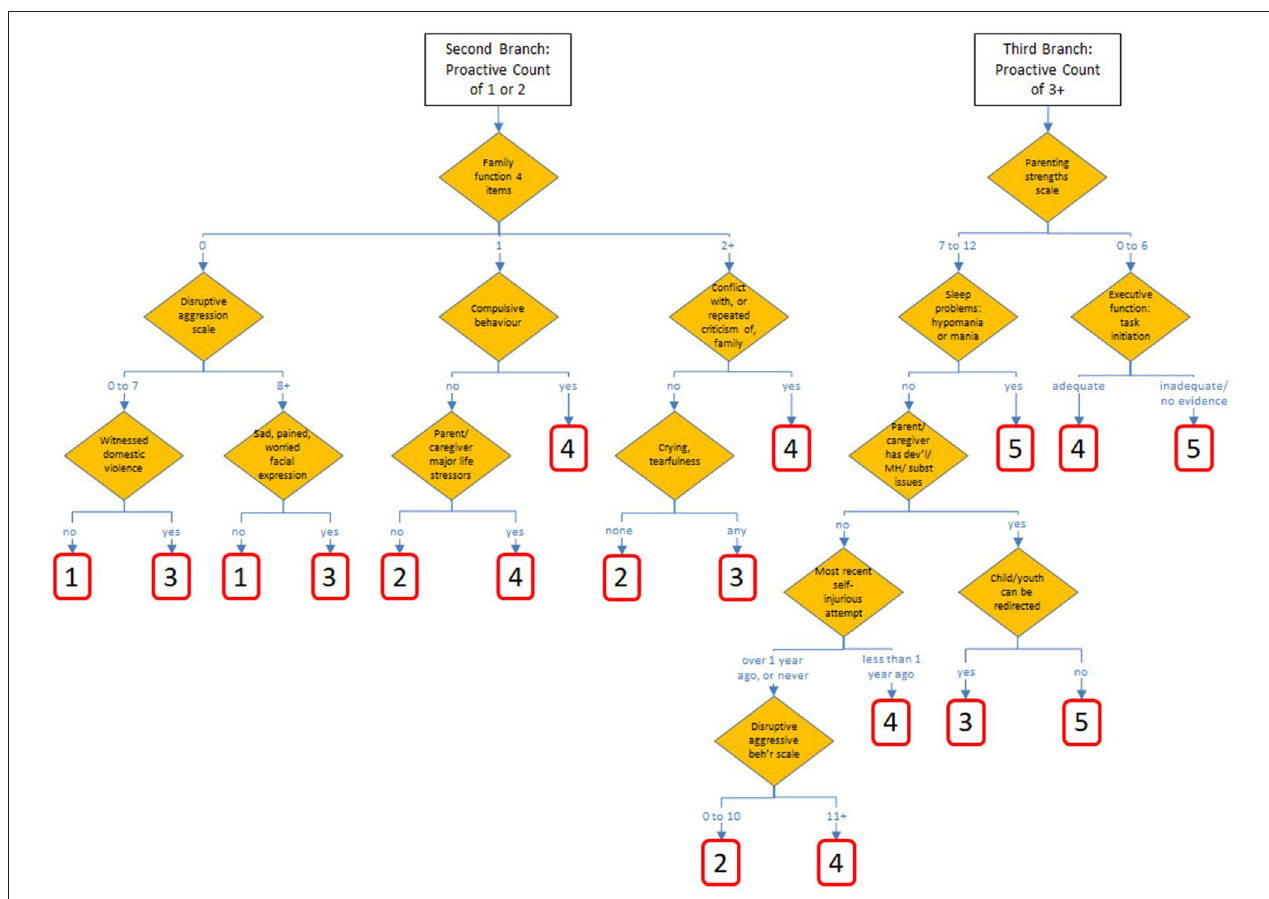
FIGURE 2 | Second and third branches of ChYMH Caregiver Distress Tree Algorithm.